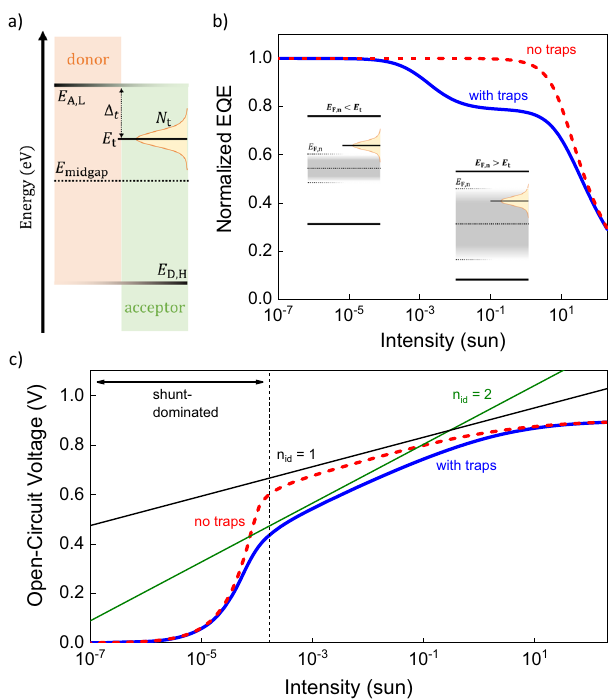
Fig. 1 Schematic energy level diagram and drift-diffusion simulations of intensity-dependent EQE and V oc in the presence of trap states. a Schematic energy level diagram of donor: acceptor BHJ solar cell with acceptor LUMO level ( E A ; L ) and donor HOMO level ( E D ; H ). The electron trap is located at an energy E t having a trap depth of Δ t ¼ j E A ; L (cid:2) E t j and trap density N t . b Comparison of simulated external quantum ef fi ciency (EQE) vs. intensity between the case with (blue, solid line) and without (red, dashed line) trap states in the donor: acceptor blend bulk. In the presence of comparably deep trap states a unique two-step EQE is seen at low and moderate intensities. The insets depict the schematic energy level E diagrams for the corresponding intensity regime, where E at low F ; n < t intensity and E F ; n > E t at moderate intensity. c The open-circuit voltage simulated as a function of light intensity, and compared for the case with (blue, solid line) and without (red, dashed line) trap states. The black and ¼ 1 green solid lines are guides to the eye with a slope corresponding to n id (i.e., without traps) and n id ¼ 2 (i.e., with traps). The vertical, dotted line marks the intensity below which the open-circuit voltage is shunt- dominated. from Fig. 1c, while the V at low and very high intensities is oc > 2) and the contacts ( n < 1) 27 , limited by shunt effects ( n id id at moderate intensities is dominated by bulk respectively, the V oc recombination. Depending on the relative balance between the ¼ 2) and bimole- fi rst-order trap-assisted recombination ( n id ¼ 1), the ideality factor transitions cular recombination ( n id from 2 to 1 resulting in arbitrary values between 1 and 2 when varying the photovoltage (through control of the incident light intensity).